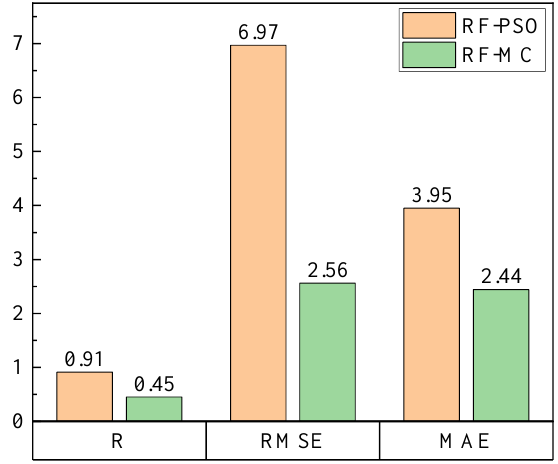
Figure 7. Comparison of the two performance evaluations.